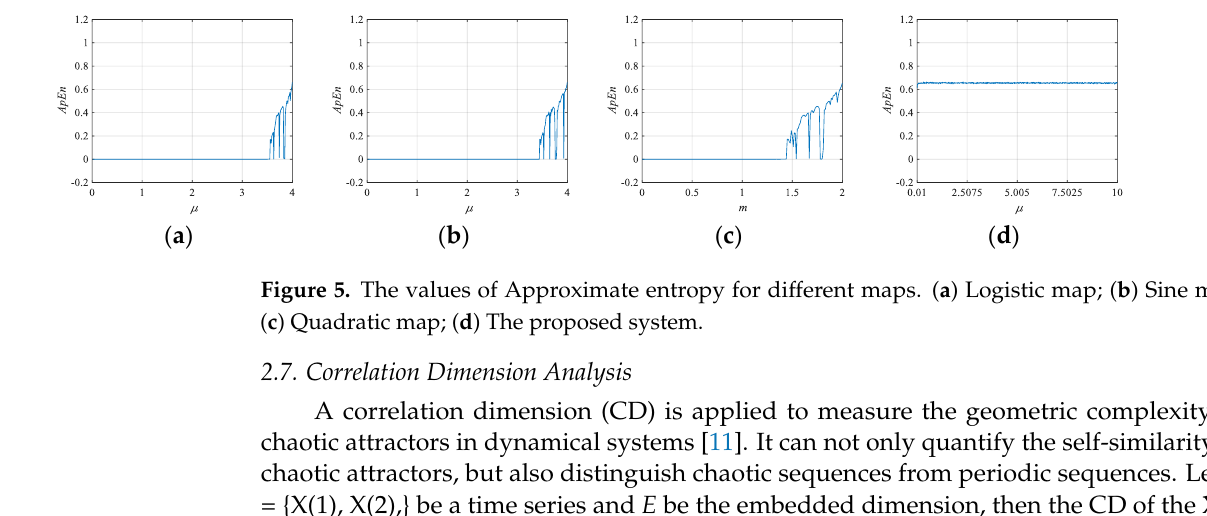
7 of 24 Figure 4. Correlation function of system (1): ( a ) Autocorrelation function; ( b ) Cross-correlation function. 2.6. Approximate Entropy Analysis Approximate entropy (ApEn) is also a means to measure the complexity of a time series. Approximate entropy describes the probability of generating new patterns in a sequence with the increase of the embedding dimension [10]. Suppose a time series of length N is u = [ u (1), u (2),..., u ( N )] and, given a positive real number r (called the time delay) and a positive integer m (called the embedding dimension), the algorithm of cal- culating ApEn can be described as follows: Select ( N - m + 1) subsequences v of length m from the sequence u : ( ) [ ( ) , ( 1 ) ,..., ( 1 )] , 1 , 2 ,..., 1 i